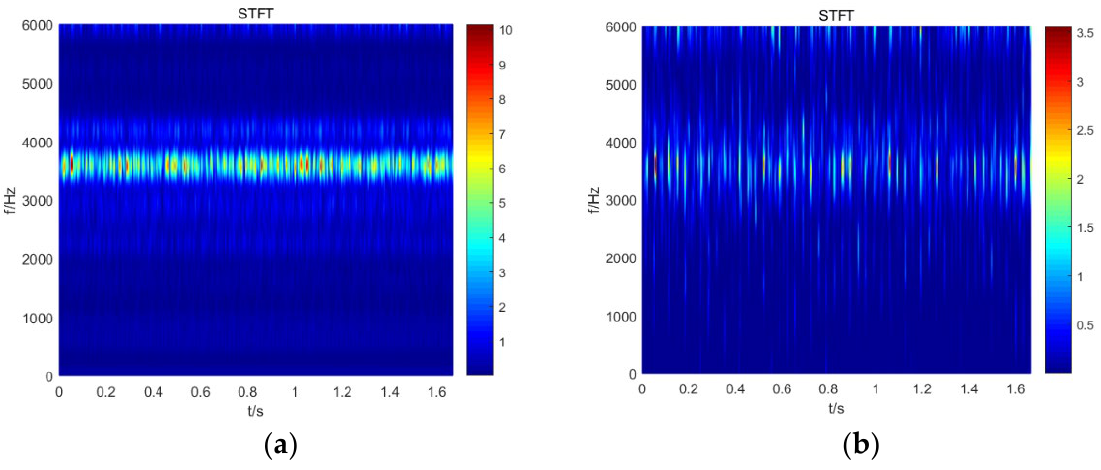
Figure 10. In 95 h: the STFT of ( a ) harmonic component; ( b ) impulse component.